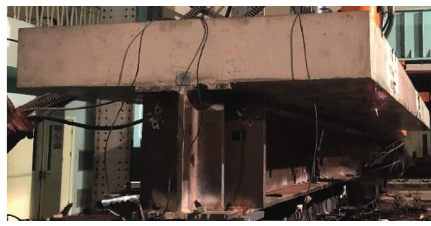
Figure 2: The field test beam.